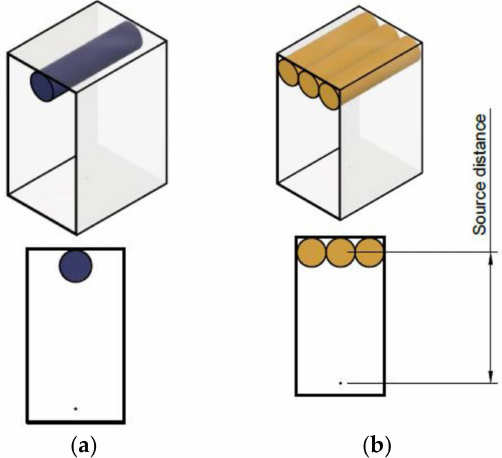
Figure 7. Schematics for; ( a ) single CsI(Na) detector setup; ( b ) triple CsI(Na) detector setup.